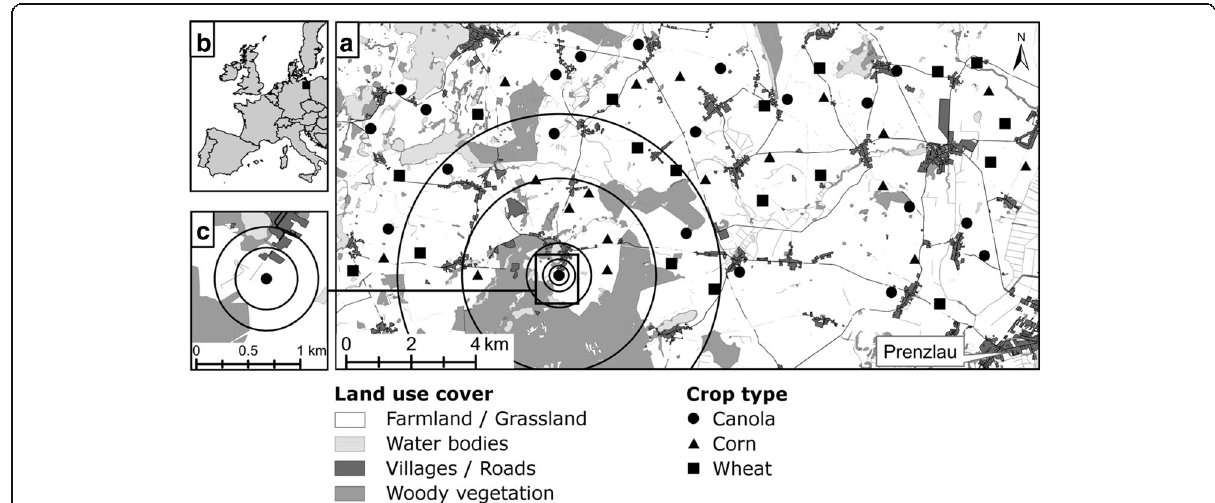
Fig. 1 Map showing the landscape composition of the study area (53° 20 ′ North, 13° 42 ′ East) ( a ) its location in Germany ( b ) and a close-up view of a site in a canola field with buffers in 300 and 500 m distance ( c ) (ArcGIS 10.0 © ESRI Inc. 1999 –